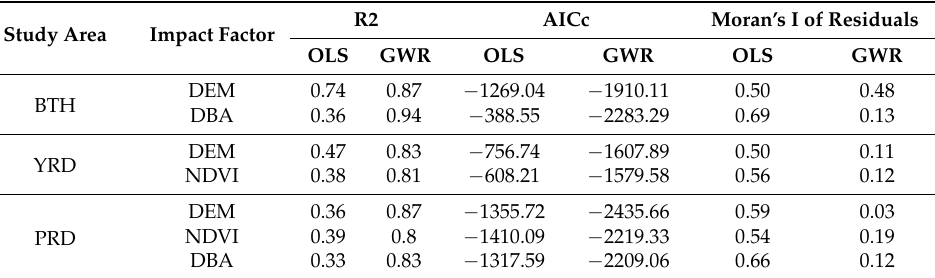
Table 4. Comparison between the geographically weighted regression (GWR) and ordinary least square (OLS) models. AICc = Akaike Information